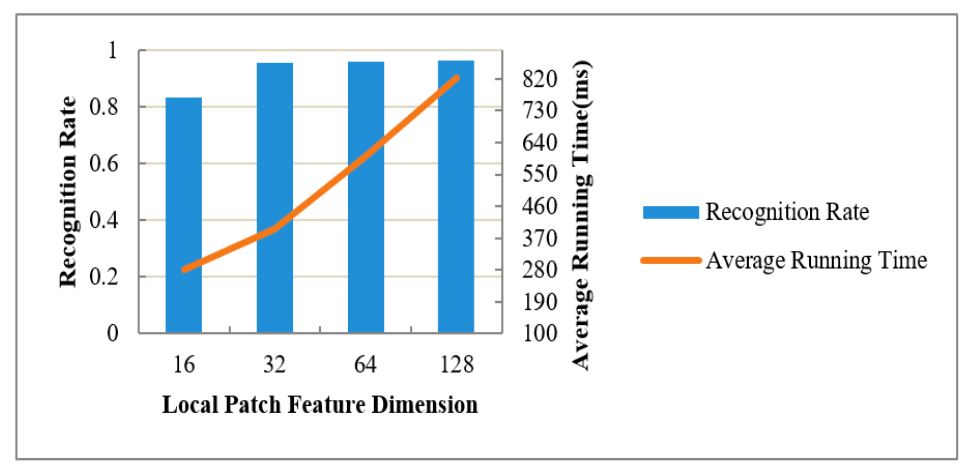
Figure 16. The influence of feature dimensions of the local image patch on recognition performance.